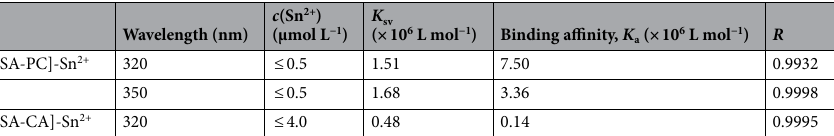
Table 3. Stern–Volmer quenching constants ( K sv ) and binding affinities ( K a ) for the interactions of catechin (CA) and PC with Sn 2+ in the presence of BSA. R is the correlation coefficient. SD is the standard